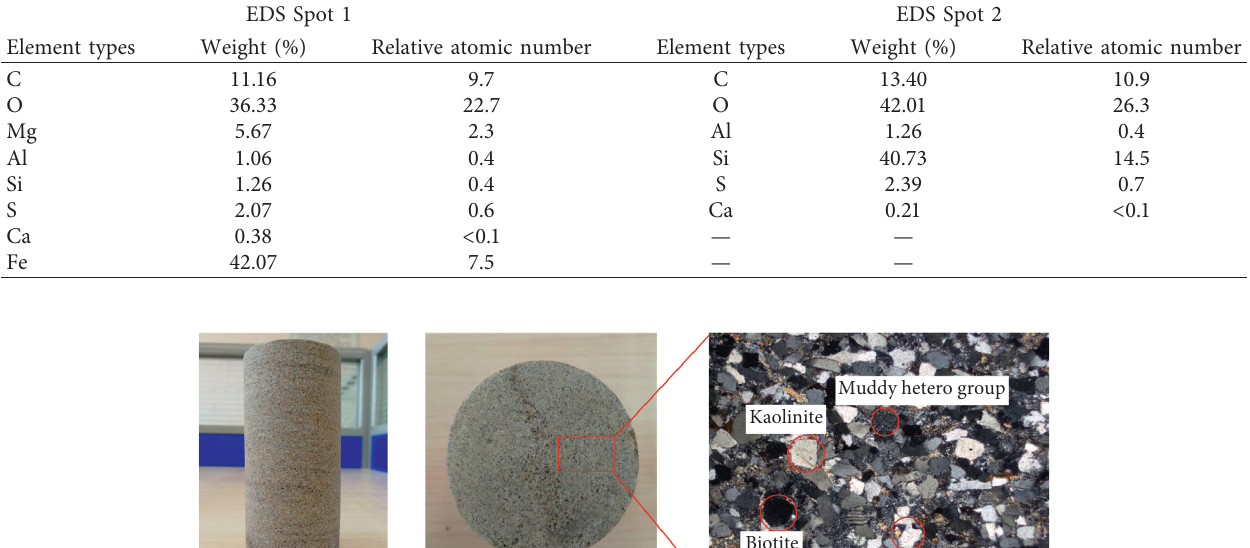
Table 1: EDS analysis results.